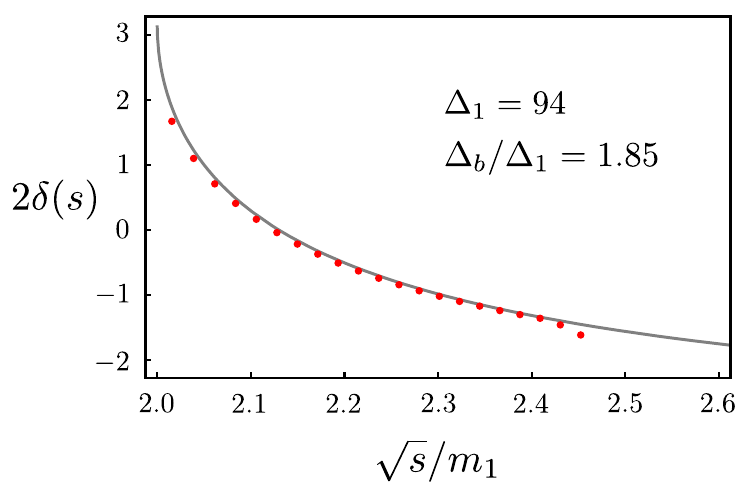
Figure 11 . Exact vs numerical phase shift. In black the exact phase shift corresponding to the S-matrix given in (4.12). The red dots are determined numerically from the conformal